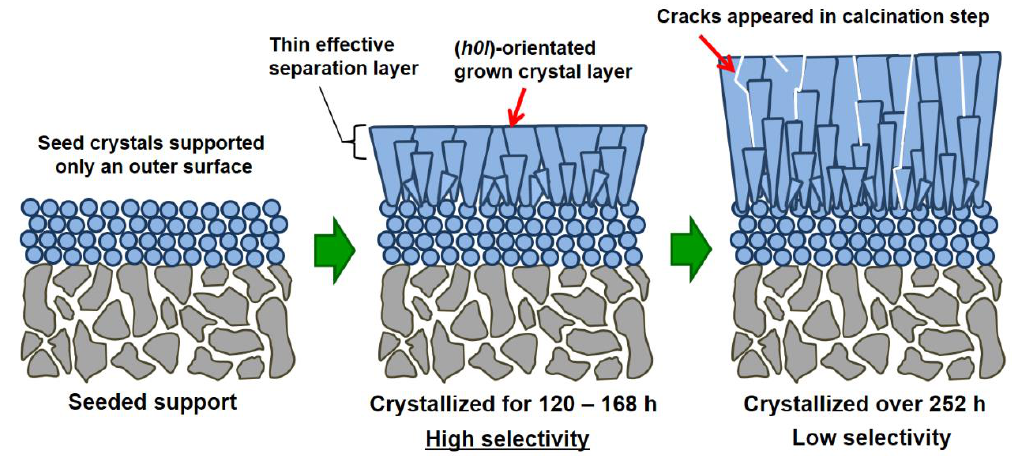
Figure 11. Model of the silicalite-1 membrane formation process.